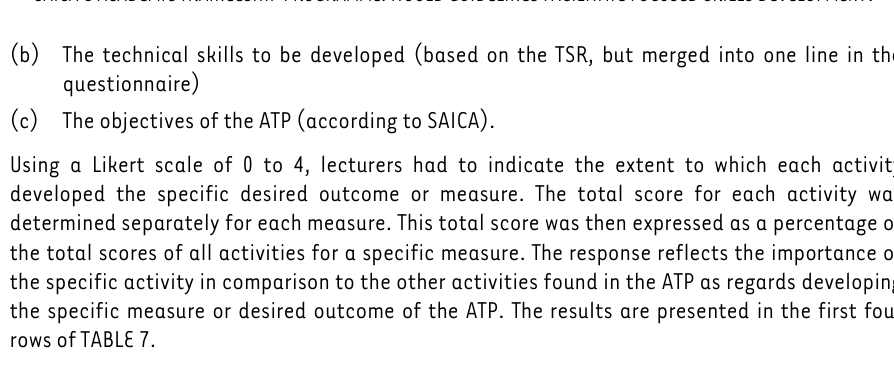
Activities performed by academic trainees Research Lectu- and/or ring and further Tutorials study